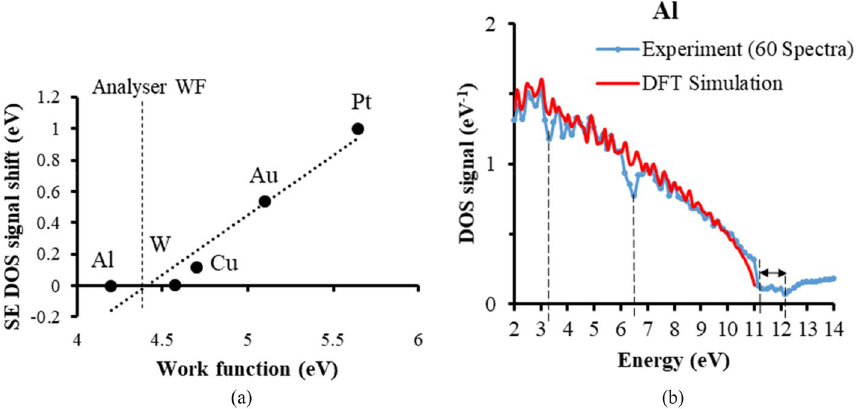
Figure 6. ( a ) Energy shift variation with sample work function. The analyser work function value of 4.4 eV is found from the fitted line intercept with the work function axis. The work function values for each metal element were obtained from Michaelson 80 , and Hölzl and Schulte 81 . The quoted accuracy for the work function values are less than ± 0.1 eV. ( b ) Energy loss information superimposed upon the experimental DOS signal, at the energies, 3.3, 6.5 and 11–12